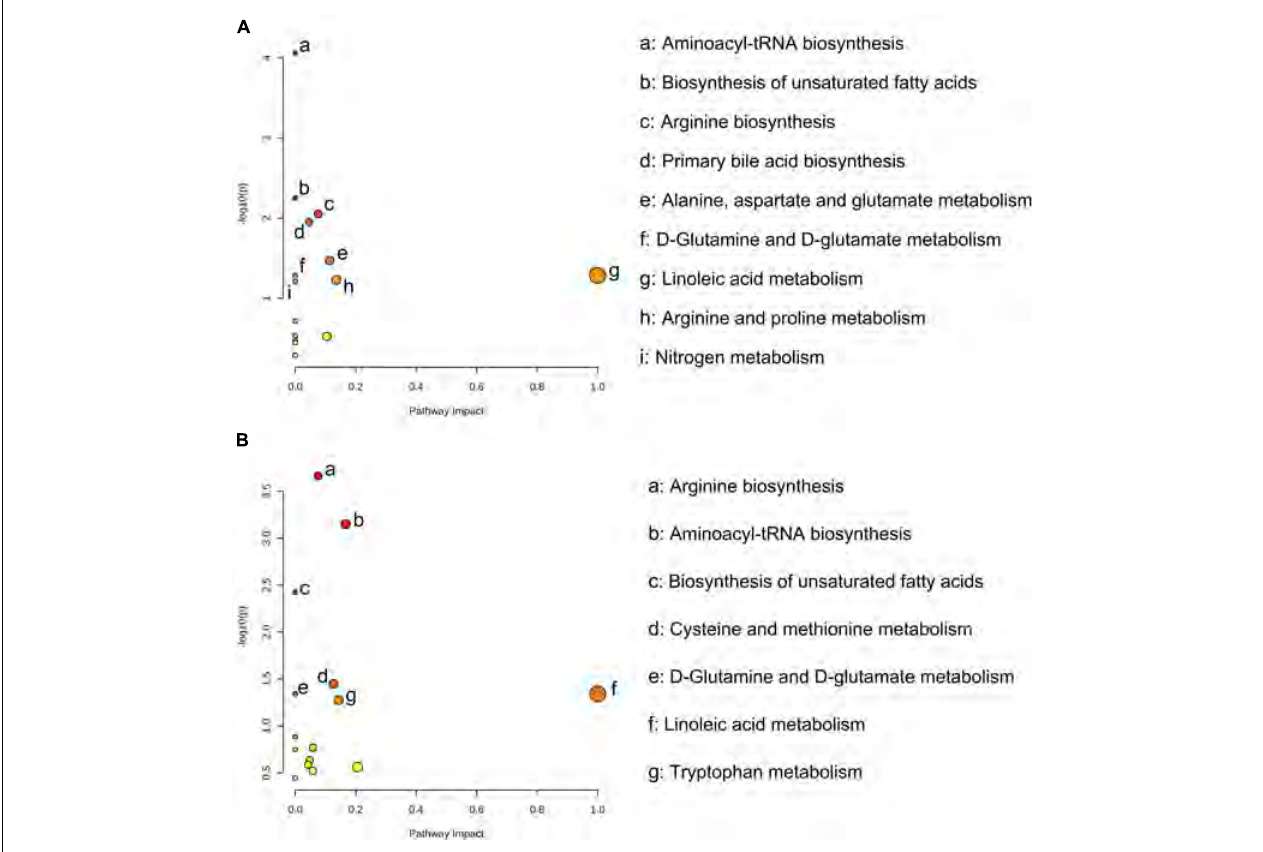
FIGURE 3 | Significantly different serum metabolites between fresh rumen fluid (FR) and saline (Con) cows, and sterilized rumen fluid (SR) and Con cows. Pathway analysis was performed using the significantly different serum metabolites between FR and Con cows (A) , and SR and Con cows (B) . Con, saline; FR, fresh rumen fluid; SR, sterilized rumen